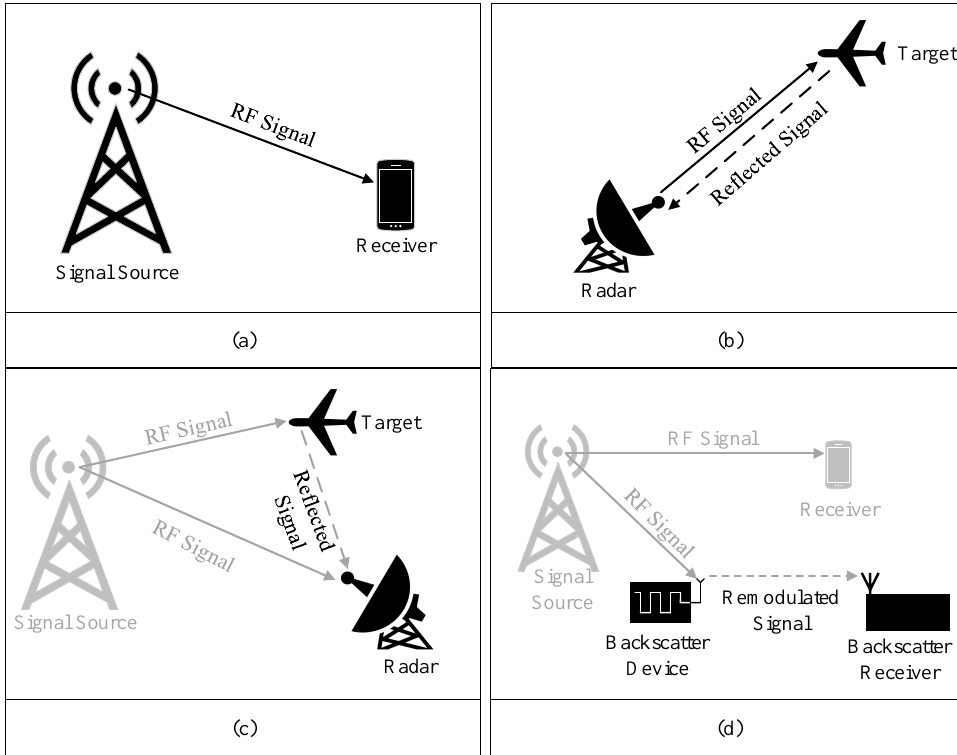
Figure 3. Classification of radio systems: ( a ) active communication system, ( b ) active RADAR/ Sensing system, ( c ) passive RADAR system, ( d ) passive communication